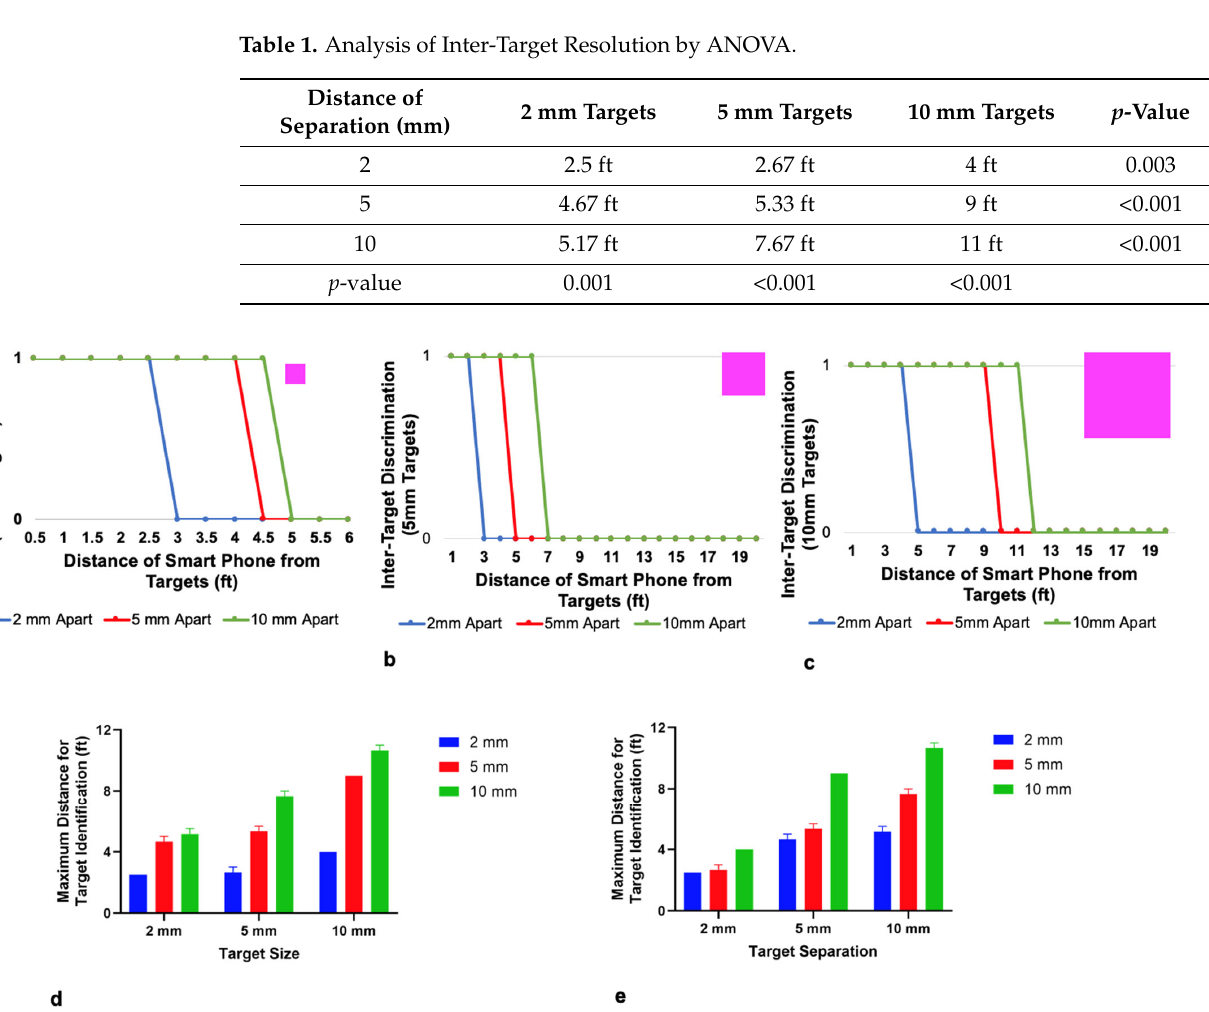
Figure 8. ( a ) 2 × 2 mm inter-target discrimination resolution. ( b ) 5 × 5 mm inter-target discrimination resolution. ( c ) 10 × 10 mm inter-target discrimination resolution. ( d ) Maximum distance for target identification relative to target size. ( e ) Maximum distance for target identification relative to target separation